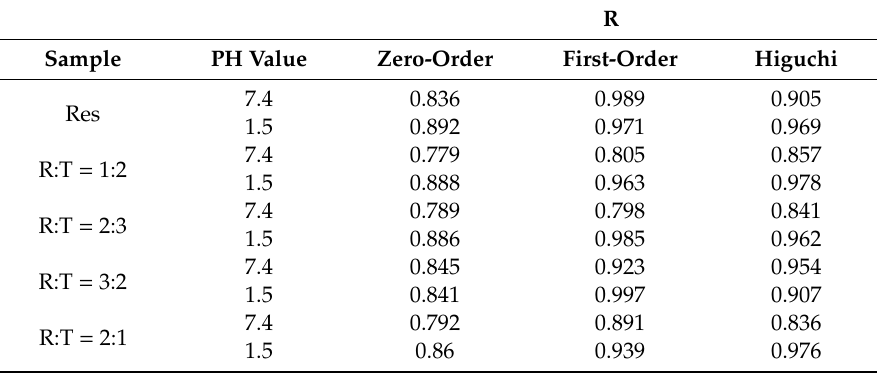
Table 1. Correlation coe ffi cients (R) for dynamic release curves.